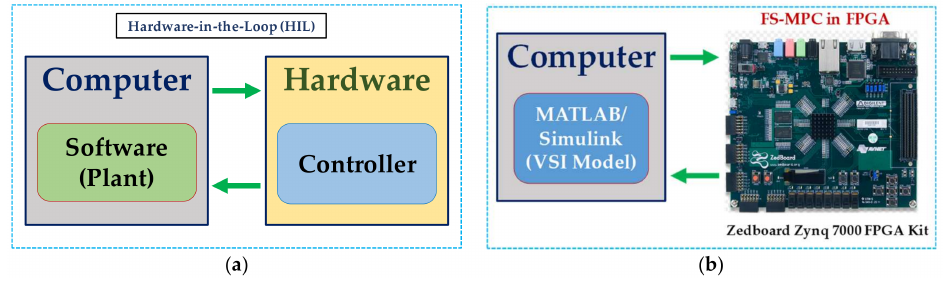
Figure 8. HIL co-simulation for the controller in hardware. ( a ) General block diagram; ( b ) VSI interaction with the controller in FPGA.